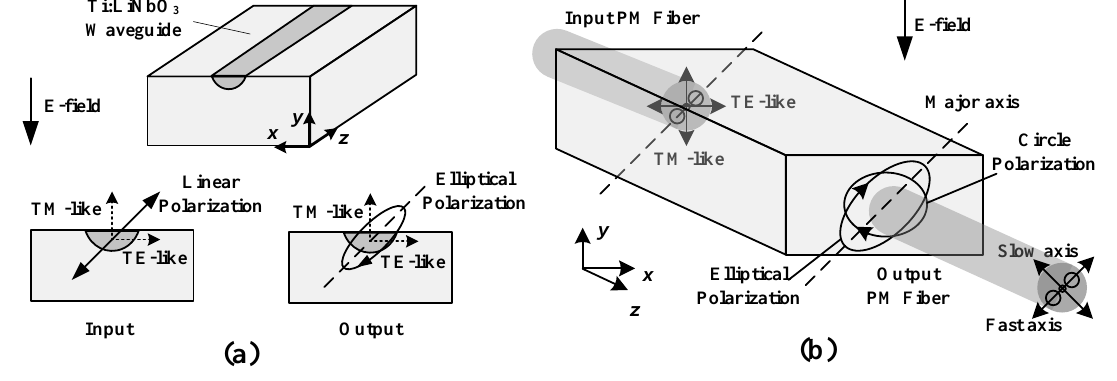
Figure 14. Structure of CPI-based IOES. ( a ) Polarization state of the input and output light; ( b ) Coupling of the fiber and the waveguide. Ti:LiNbO 3 zy x